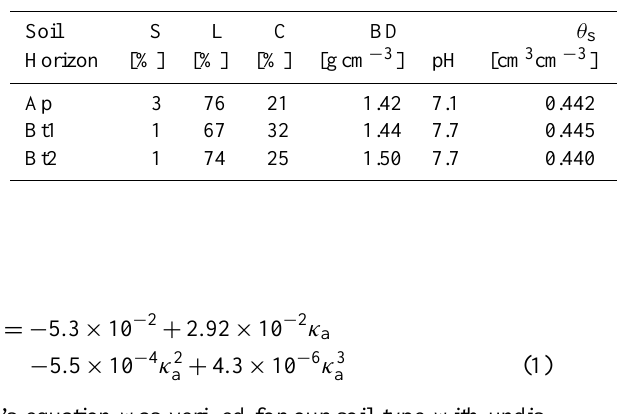
Table 1. Textural and hydraulic properties for each soil horizon (Weynants, 2011). S, L and C respectively represent the percentage of sand, loam and clay; BD is the soil bulk density; θ r and θ s are the saturated and the residual SWC, respectively. α , n , and l are the Mualem-van Genuchten parameters.